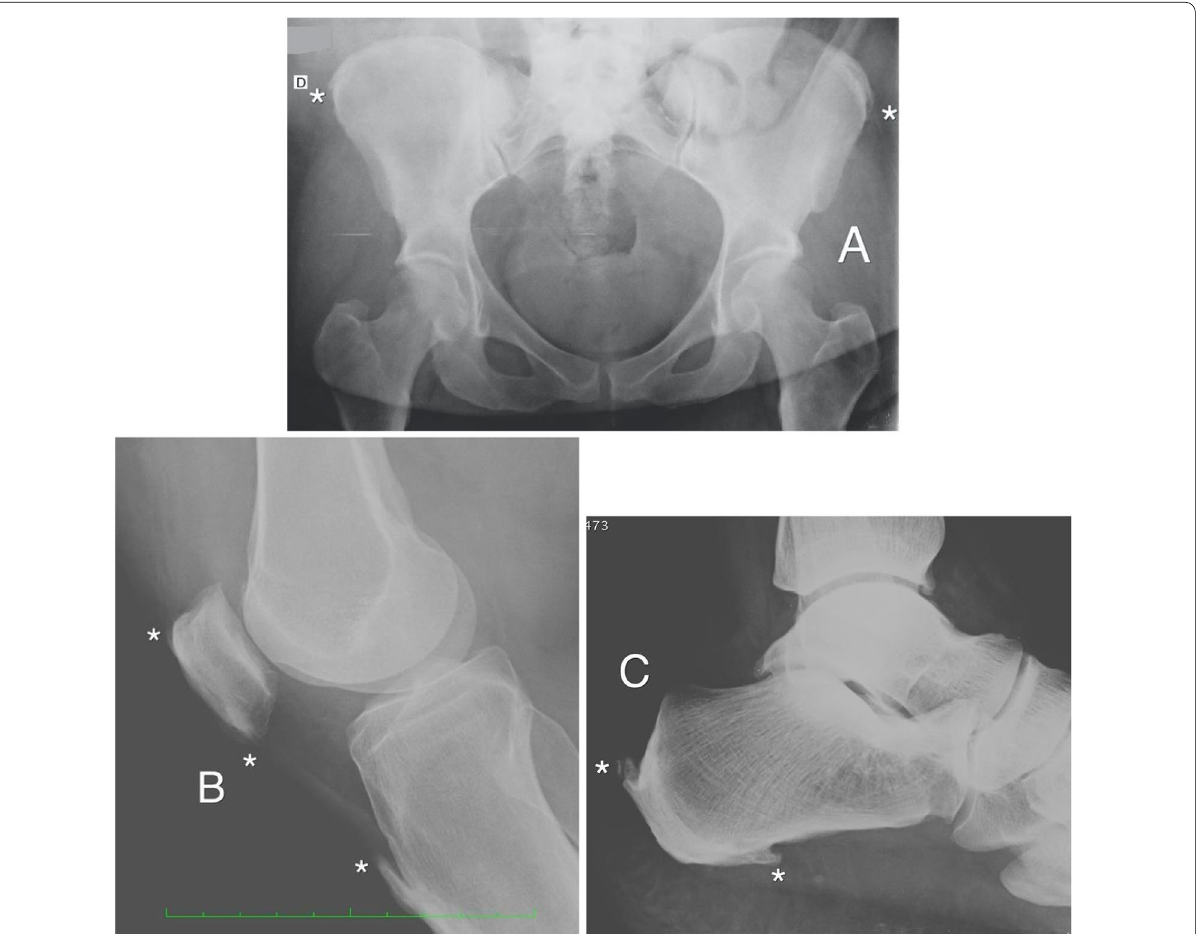
Fig. 1 Presence of Enthesopathy Without Joint Space Narrowing or Osteophytes in a 48-year-old Female With HAAP. Enthesophytes (*) seen in iliac crests ( A ); patellar insertion of quadriceps tendon and patellar and tibial insertions of the patellar tendon ( B ); calcaneal insertions of calcaneus tendon and plantar fascia ( C